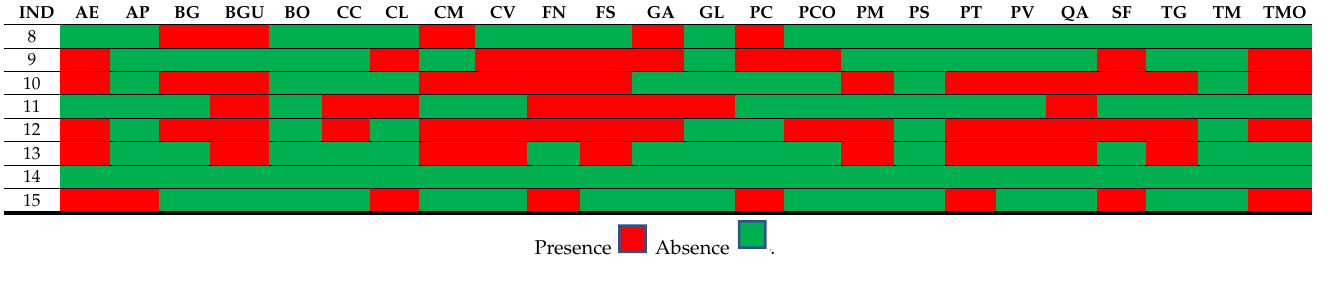
Table 5. Results obtained for the Accessibility/Facilities indicators of the different UFs.